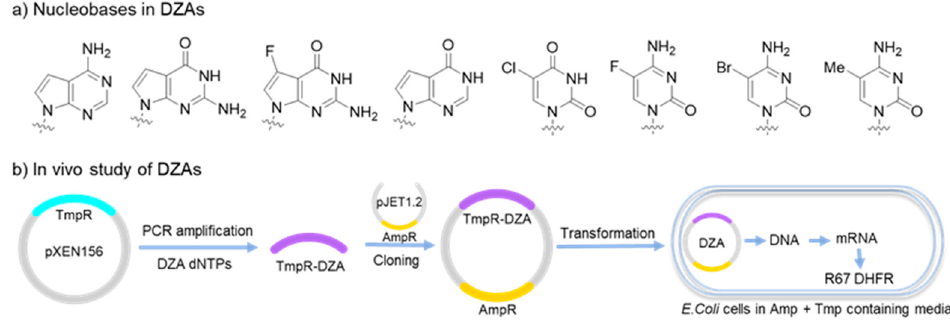
Figure 8. DZAs as alternative genetic materials. ( a ) Non-canonical nucleobases used in DZAs; ( b ) DZAs used as genetic template in bacterial cells.